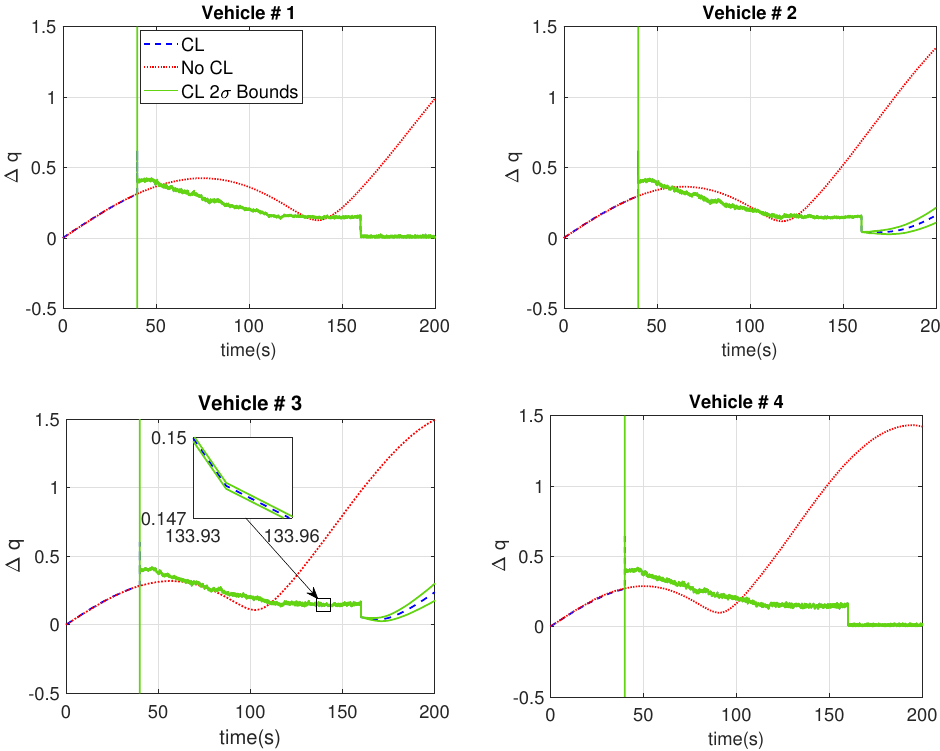
Figure 6. Time history of vehicle orientation error norm in the test